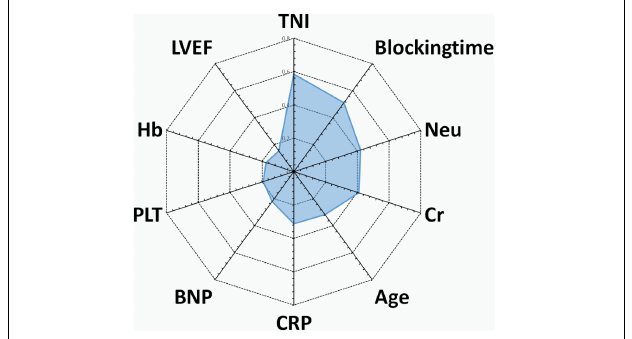
FIGURE 3 | Radar chart of the 10 most important predictors of poor prognosis screened by the PRIME score. For each important predictor, standardized beta coefficients of overall population are shown. Blocking time, blocking time of the ascending aorta during surgery; BNP, brain natriuretic peptide; Cr, serum creatinine; CRP, C-reactive protein; Hb, hemoglobin; Neu, neutrophil count; PLT, platelet count; TNI, cardiac troponin I; LVEF, left ventricular ejection